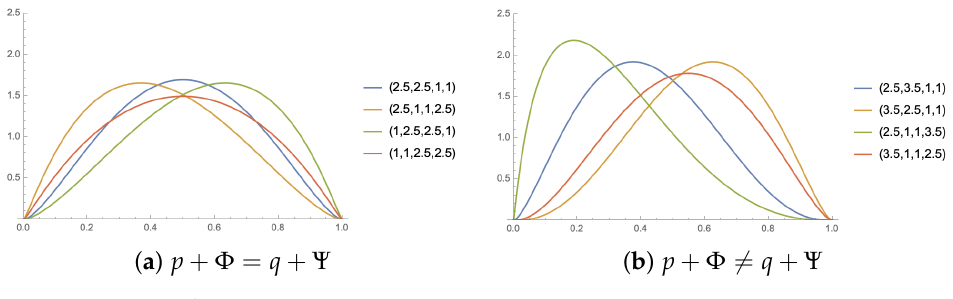
Figure 1. BetaBoop